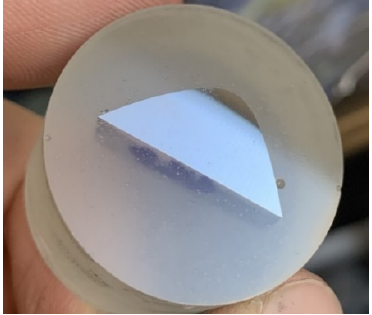
Figure 7. Sample ready for microhardness measurement.